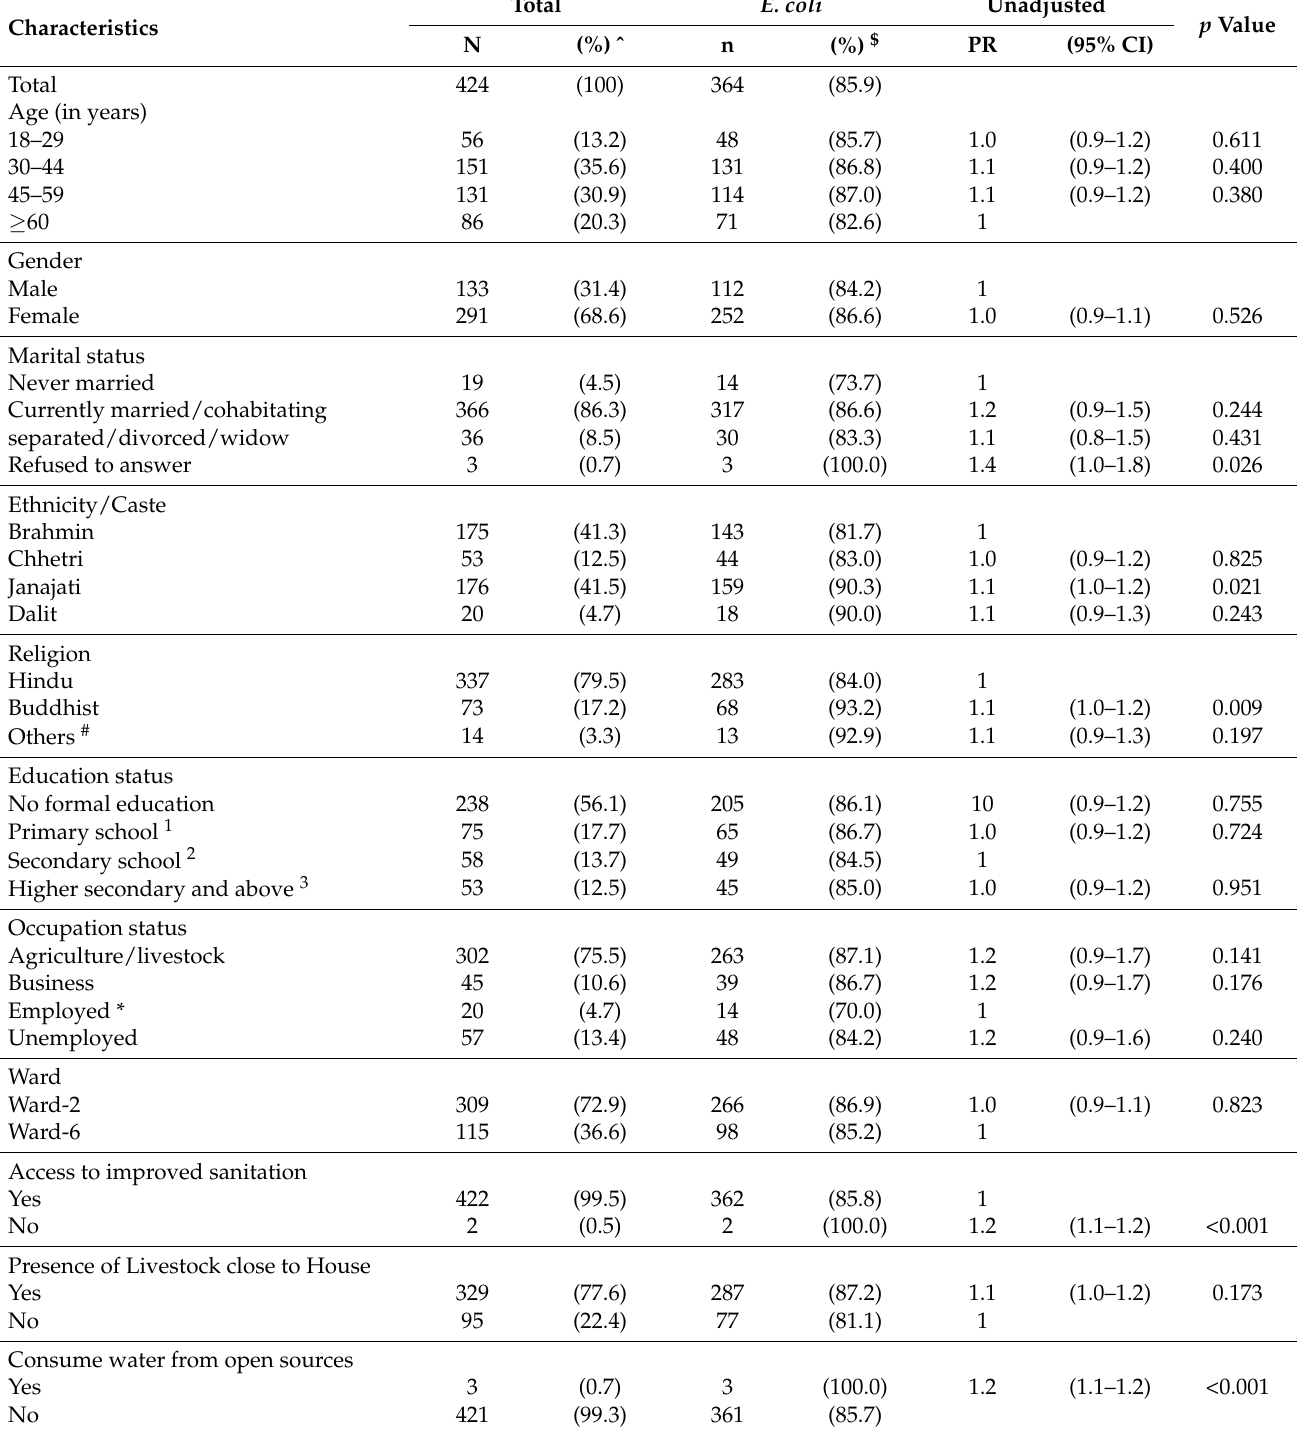
Table 1. Sociodemographic and environmental factors associated with presence of E. coli among adults of Dhulikhel municipality of Nepal from September to December